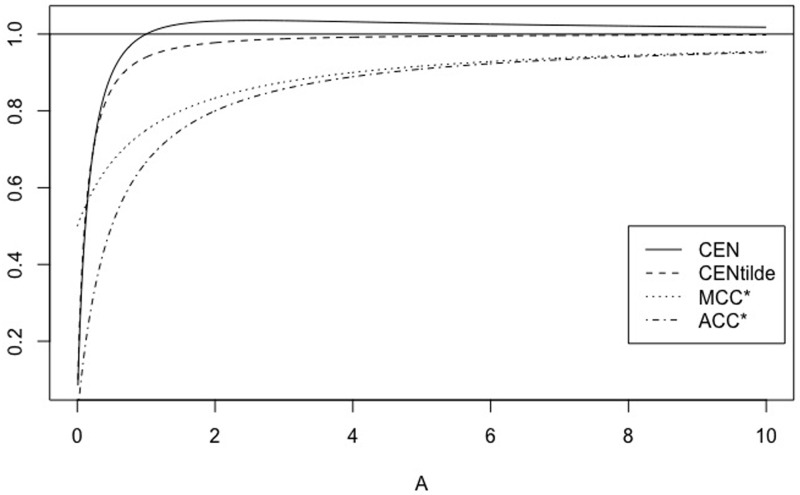
Famlily UA.CEN, MCEN, ACC* and MCC* for A ∈ (0, 10].